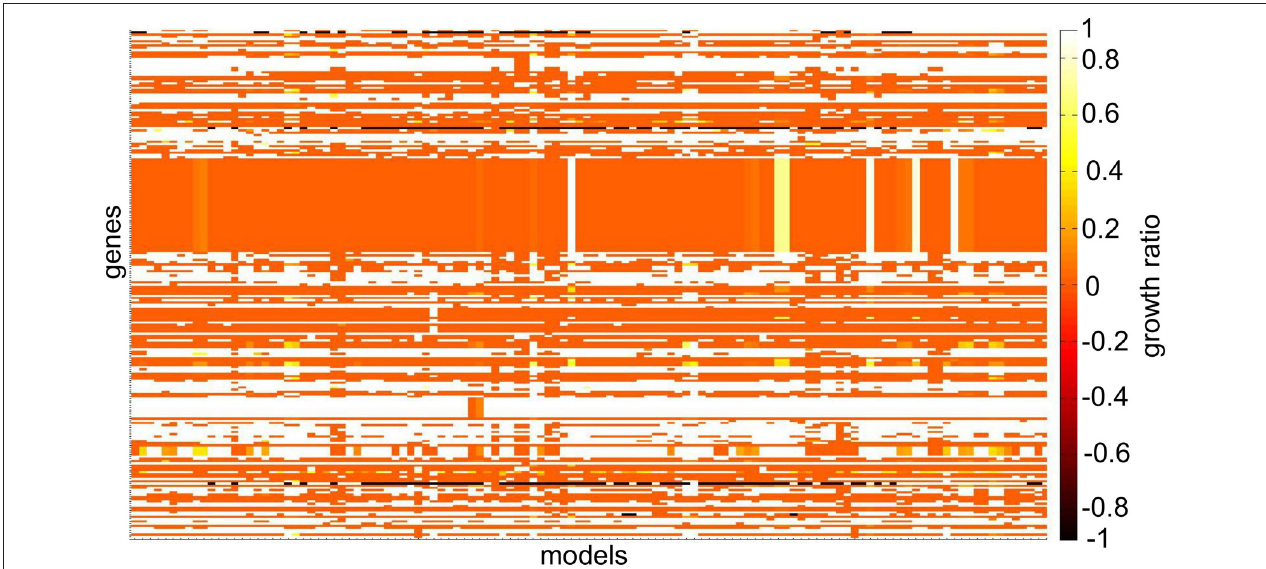
FIGURE 6 | Heat-map depicting differences in single gene deletion across 120 NCI-60 cell line models. The growth ratio is defined as the maximal objective value of the model divided by the maximal objective value of the model when the gene was deleted when optimizing for biomass production. Genes that were absent in individual models have a growth ratio value of –1. Genes that were absent in all models and genes whose deletion did not affect any model are not illustrated. The coloring in the heat-map corresponds to the maximal objective values obtained from flux balance analysis at each step of the